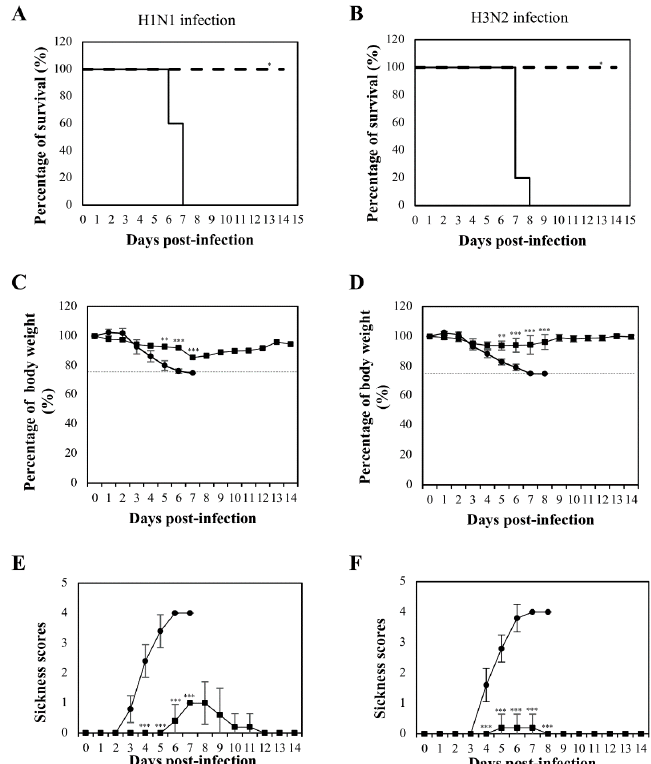
Figure 2. Mortality and morbidity of BALB / c mice after lethal influenza A virus infections. Survival rate of mice infected with ( A ) H1N1 and ( B ) H3N2. Solid and dashed lines indicate the survival rates of the mice immunized with NvC and NvC-M2ex3, respectively. Percentage of body weight of mice infected with ( C ) H1N1 and ( D ) H3N2. Dashed lines indicate endpoint of the animals. Morbidity of mice